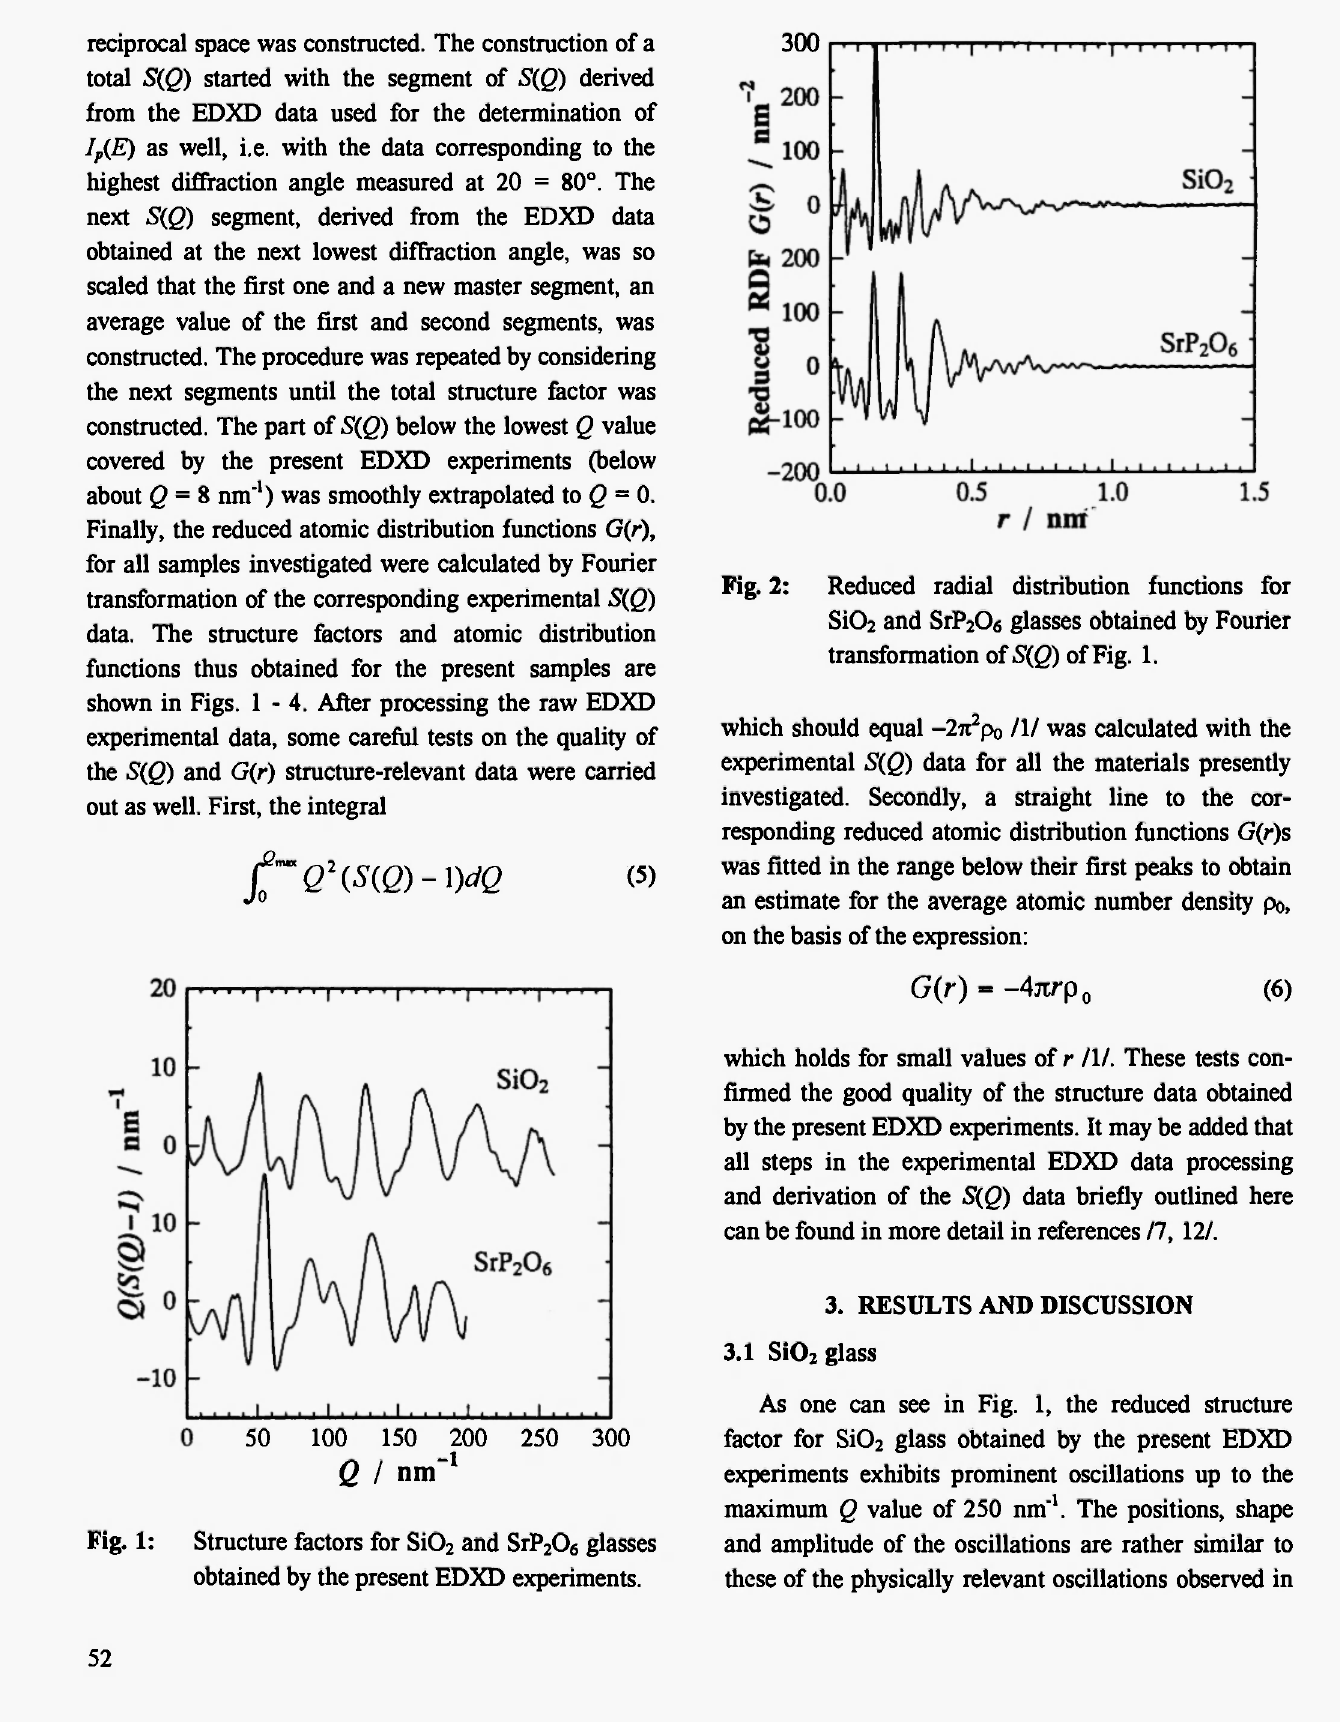
Fig. 1: Structure factors for Si0 obtained by the present EDXD experiments.